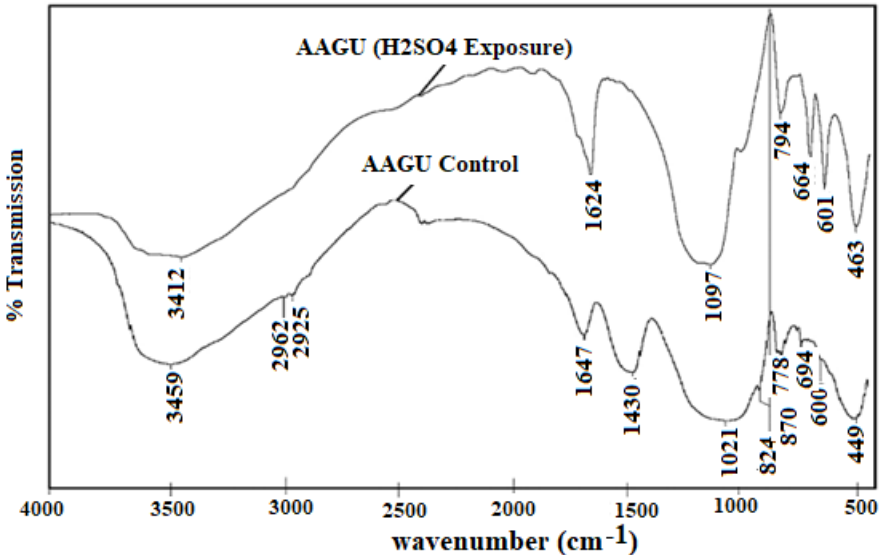
Figure 12. Sulfuric acid attack of palm oil fuel ash/slag alkaline binders (From JMCE Ref. [100] and used with permission).